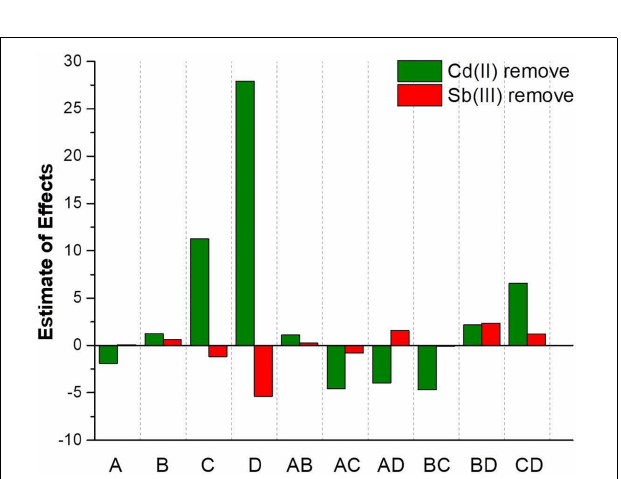
FIGURE 5 | Impact assessment of different factors on Cd(II) and Sb(III) biosorption by XK8.